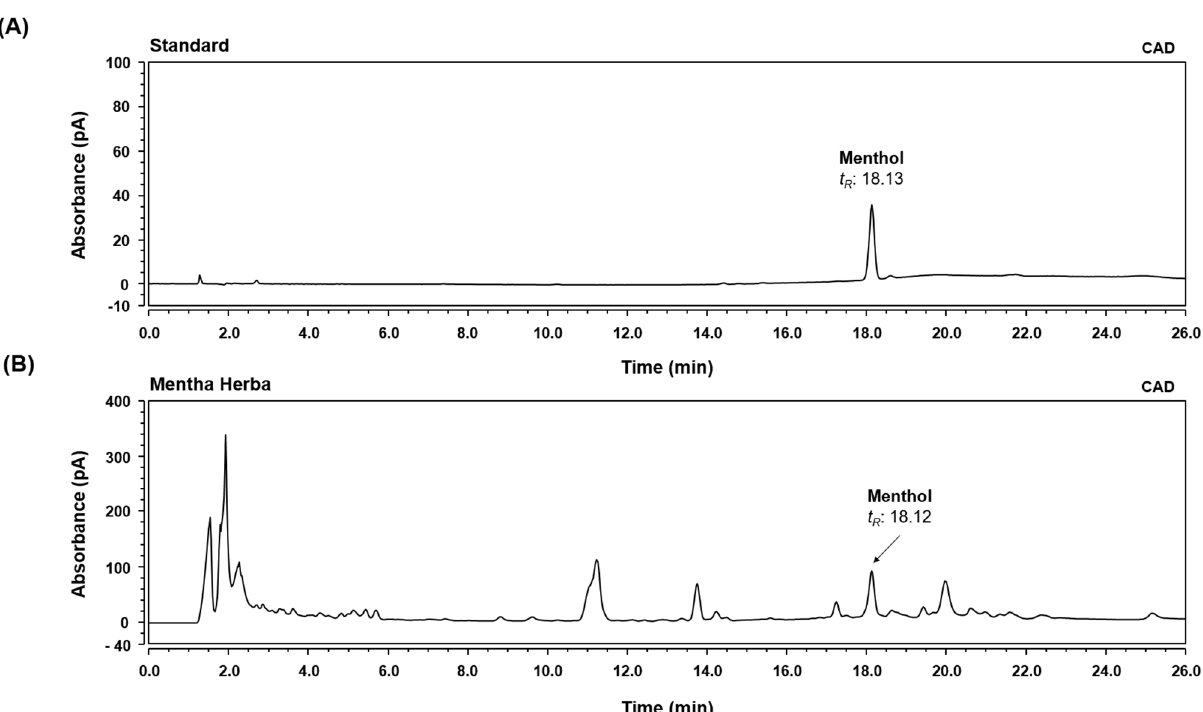
Figure 1. HPLC-CAD analysis of menthol in Mentha Herba (MH). CAD chromatogram of standard solution ( A ) and MH ( B ).